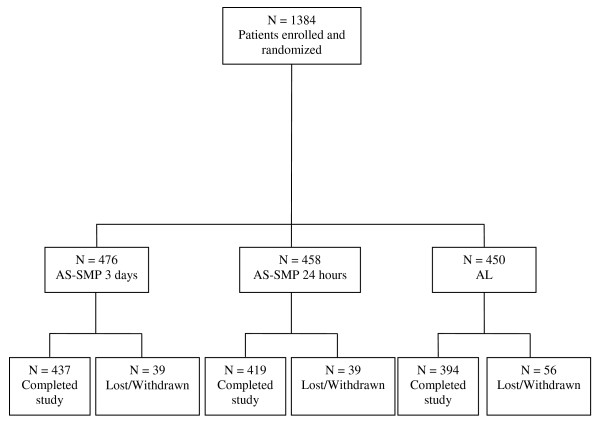
The trial profile.